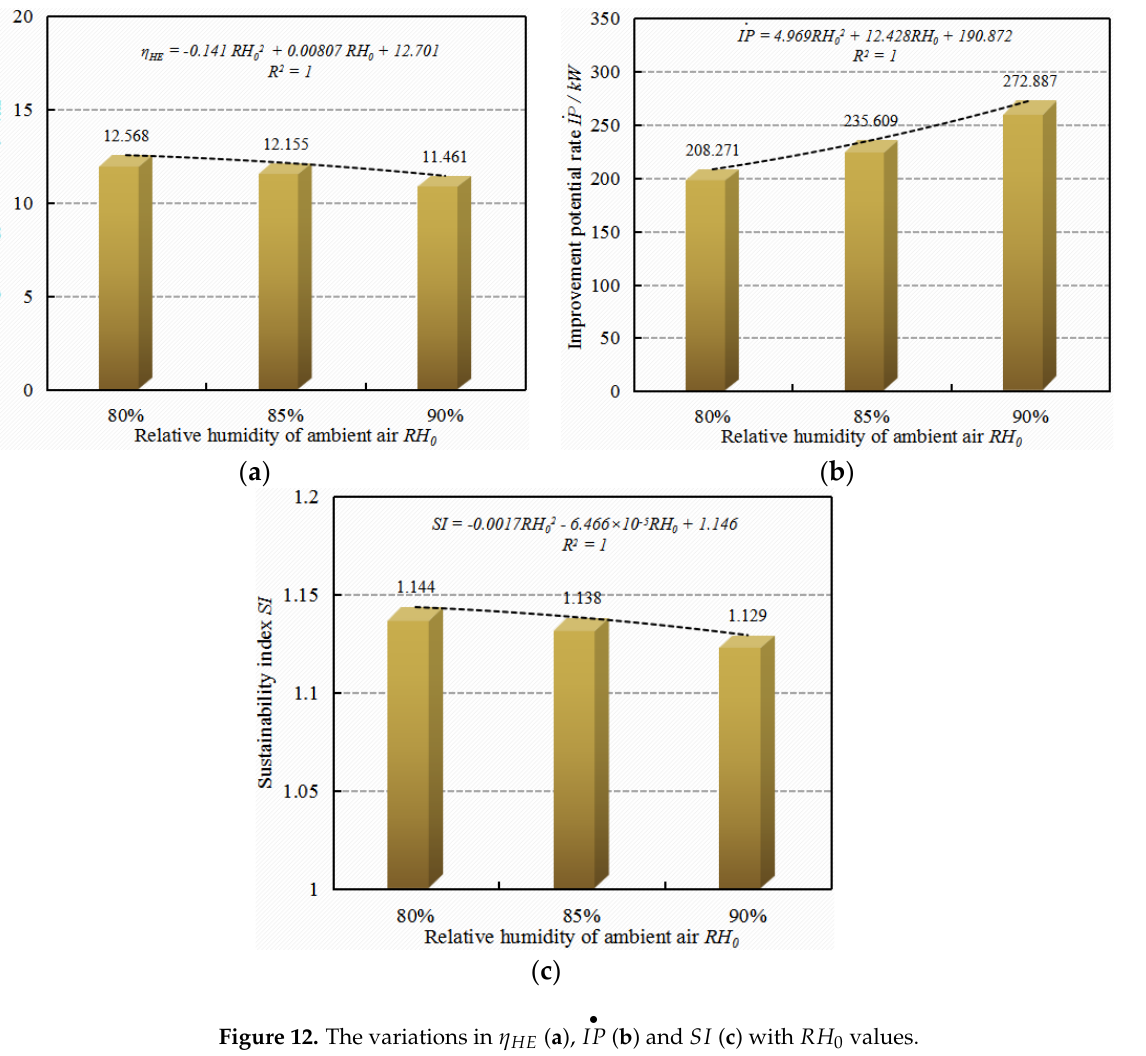
• IP ( b ) and SI ( c ) with RH 0 values. Figure 12. The variations in η HE ( a ), Figure 12. The variations in values. • IP ) is an effective index for evaluating the improvement in Improvement potential ( the exergy efficiency for a process or a system. The variations in the